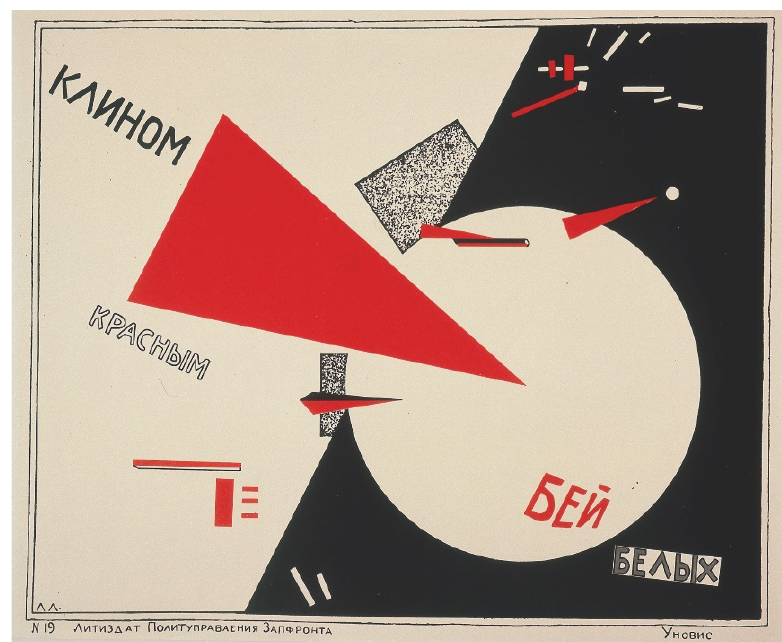
Figure 9. El Lissitzky, ‘The Red Wedge Against the Whites’, 1920, reprint 1966.